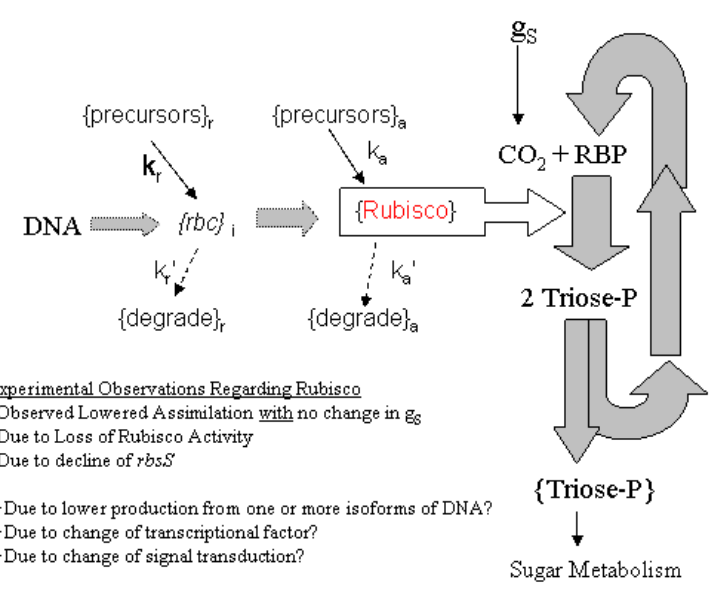
FIGURE 4. The production of Rubisco and its Calvin Cycle pathway reactions. Schematic of the movement of information from DNA (starting at the left) to the production of the protein, Rubisco (ribulose 1,5-bisphosphate carboxylase/oxygenase), and its integration into the Calvin Cycle (cyclic arrows on right). CO 2 levels are controlled by the stomatal conductance (g S ). The sequence of changes is from Pell’s